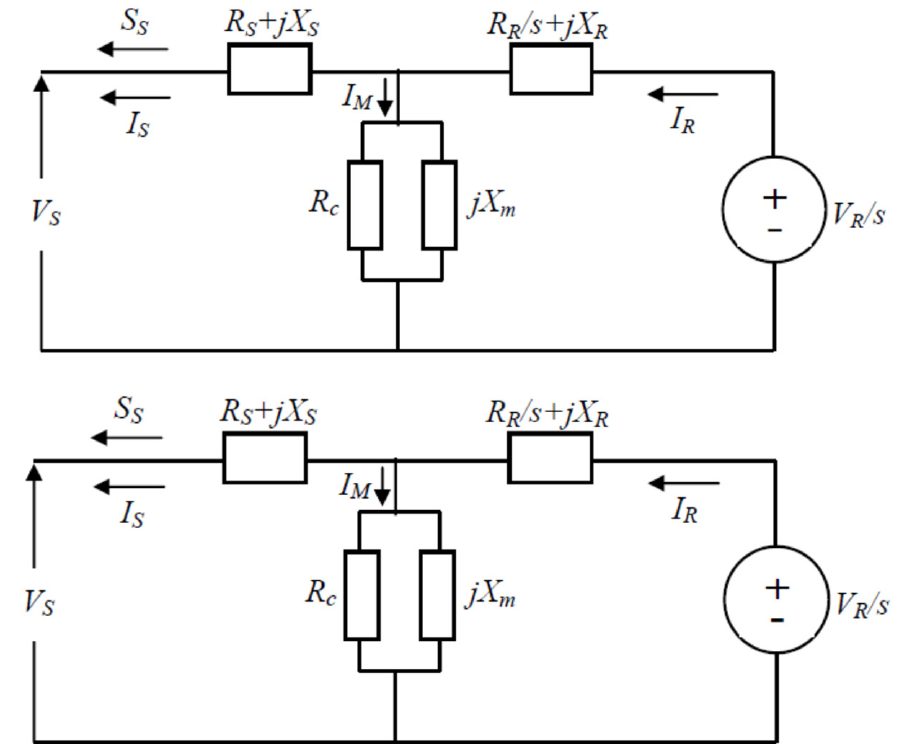
Figure 2. Equivalent circuits of WRIG.